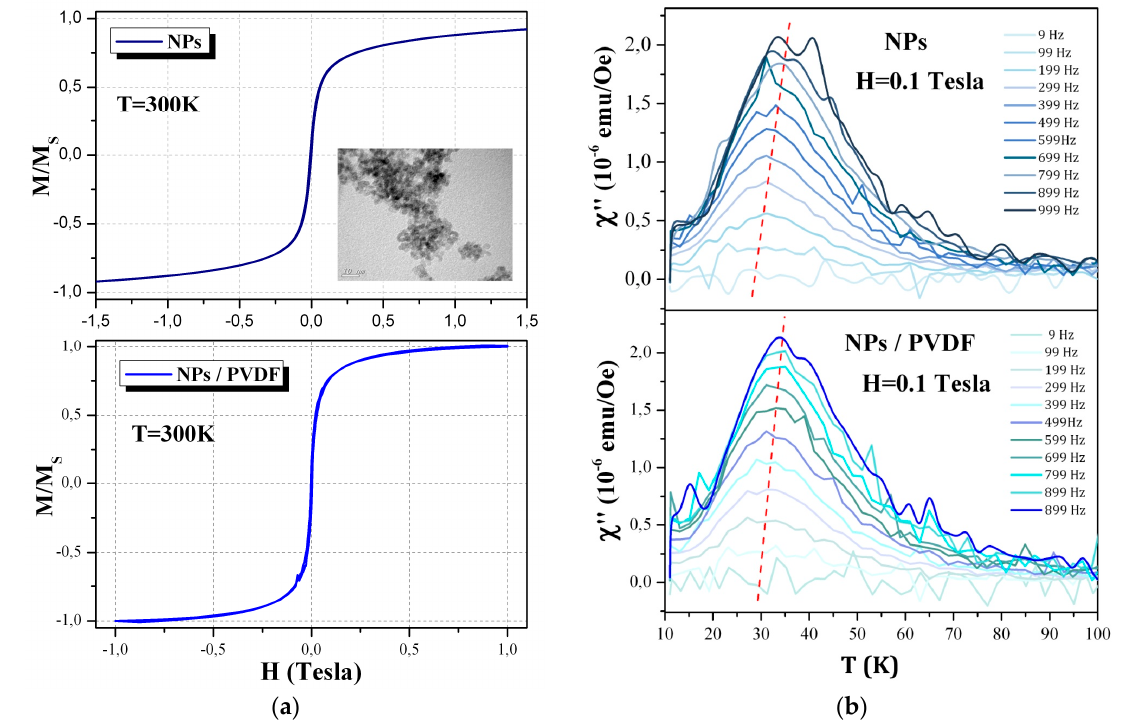
Figure 8. ( a -top) hysteresis cycle at room temperature of Co-based nano-inclusions (inset: TEM image of the nanoparticles) and ( a -bottom) composite film containing 1 wt % of functionalized nano-inclusions; ( b -top) magnetic susceptibility as function of temperature for Co-based nano-inclusions and ( b -bottom) composite film containing 1 wt % of functionalized nano-inclusions.